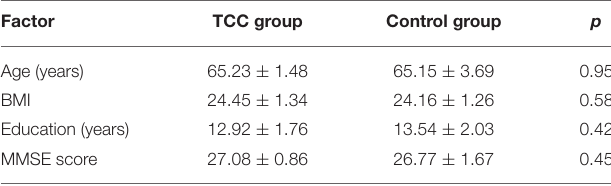
(MMSE) score ≥ 24; (6) exercised 1 h a day. All the subjects TABLE 1 | Demographic data of the participants (M ±